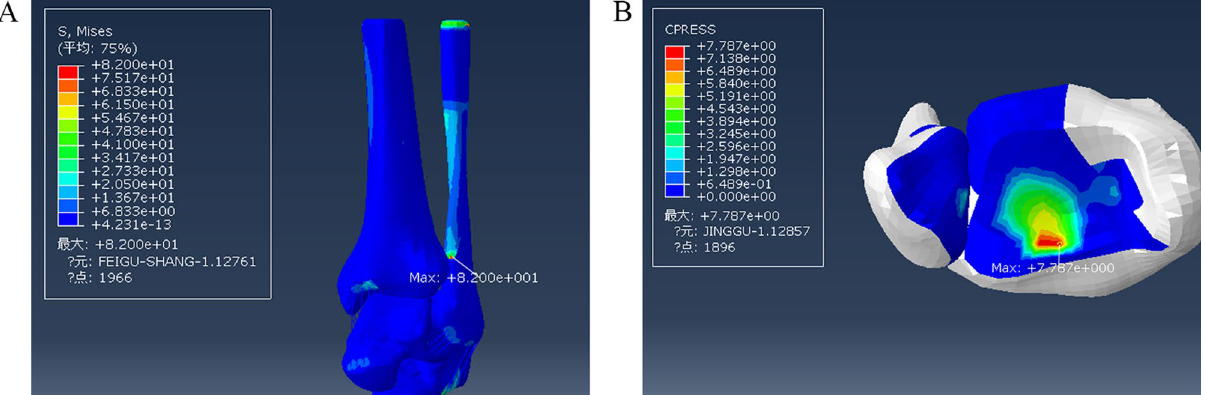
Figure 8. Distribution of stress during injury of the lateral malleolar fracture in a stage II supination-external rotation ankle injury. ( A ) Maximum stress view. ( B ) Maximum contact stress view. Units of measurement: Mpa.